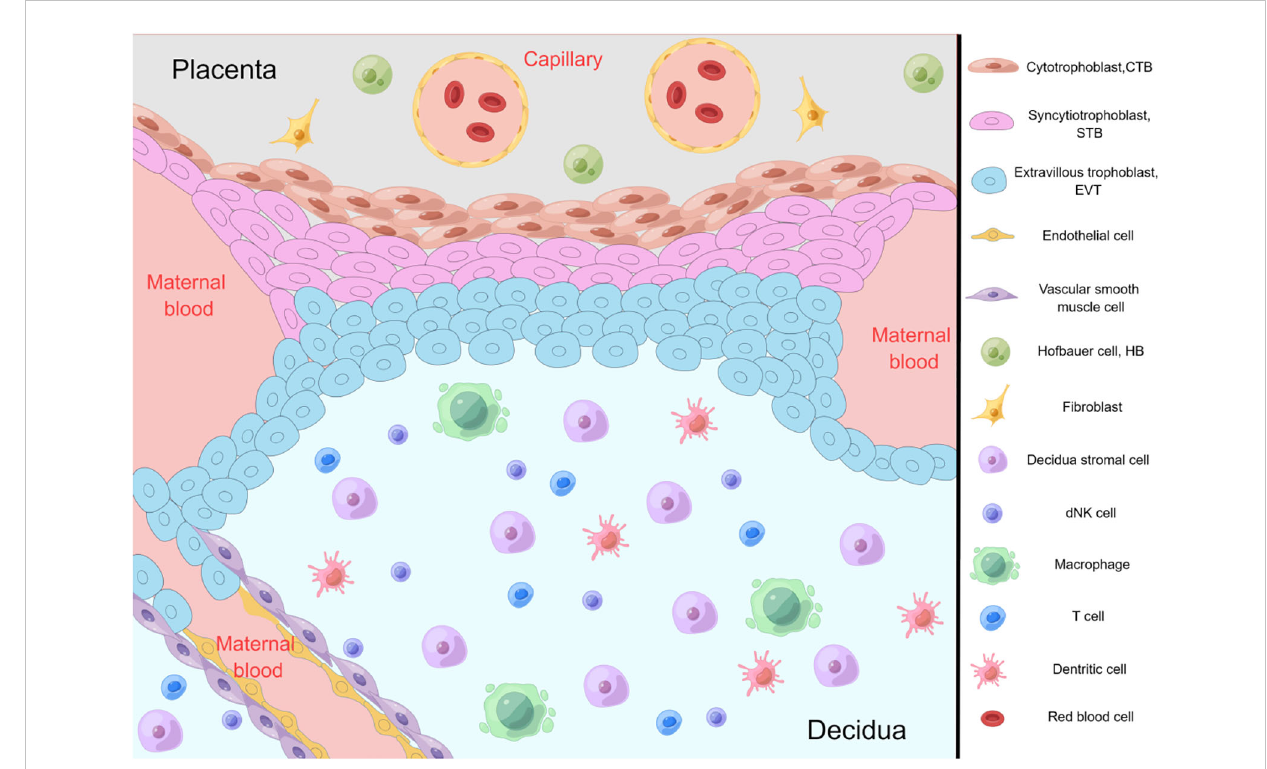
FIGURE 1 Diagram of cellular components at the maternal-fetal interface. By